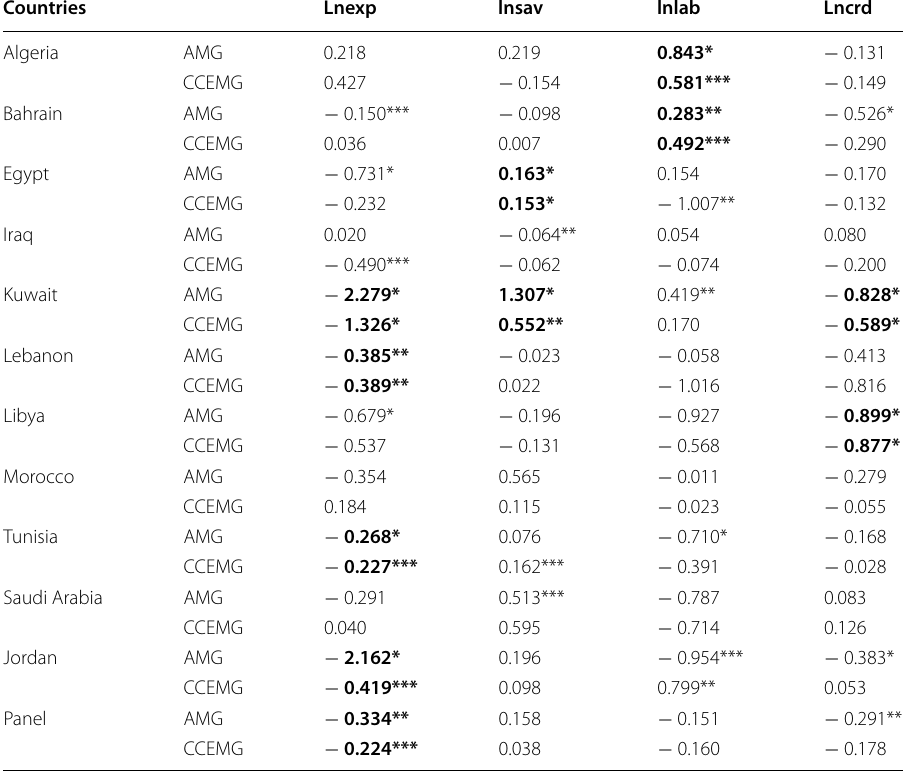
*, **, and ***Indicate the rejection of the null hypothesis at 1%, 5%, and 10% significance levels, respectively